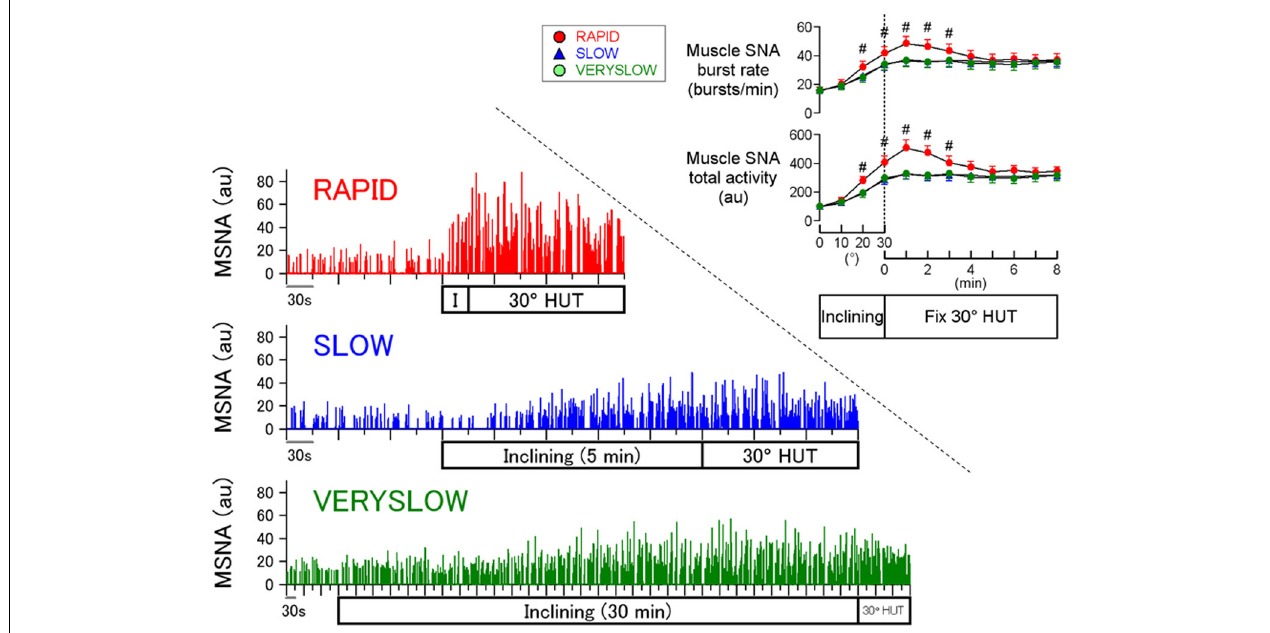
FIGURE 1 | Human MSNA responses to HUT tests with RAPID, SLOW, and VERYSLOW inclining speed. # P < 0 . 05 vs. SLOW and VERYSLOW tests. Error bars denote standard error. Modified from the study: Kamiya et al. (2009).